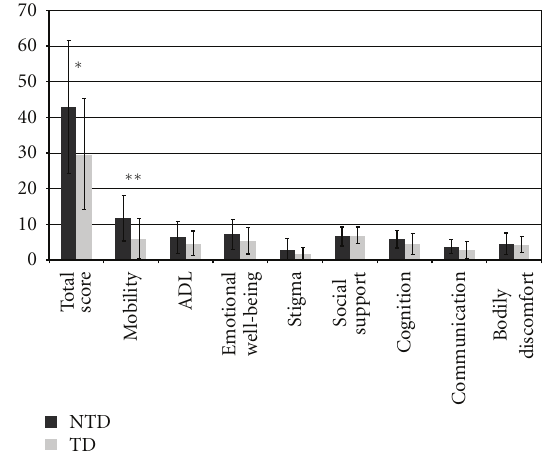
Figure 1: Mean subscale scores on the PDQ-39 for NTD and TD participants; ∗∗ P < . 01, ∗ P < .